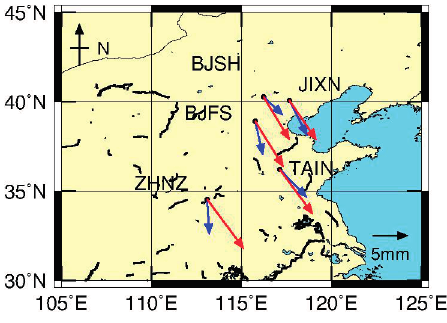
Figure 7. Comparison of annual amplitudes and initial phases between GPS (blue) and GRACE (red). The amplitude A and initial phase f are defined as A sin[ w ( t − t 0 ) + f ], where t 0 is 2004.0 and f is the angular initial phase lag in degrees. The blue and red vectors represent the amplitudes and initial phases derived from GPS and GRACE. The initial phases are counterclockwise from the